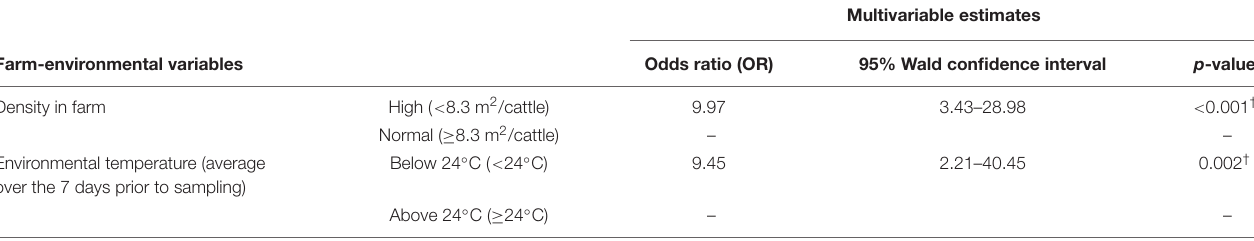
TABLE 2 | Farm-environmental variables associated with C. jejuni prevalence on dairy cattle farm using multivariable generalized estimating equations (GEE)